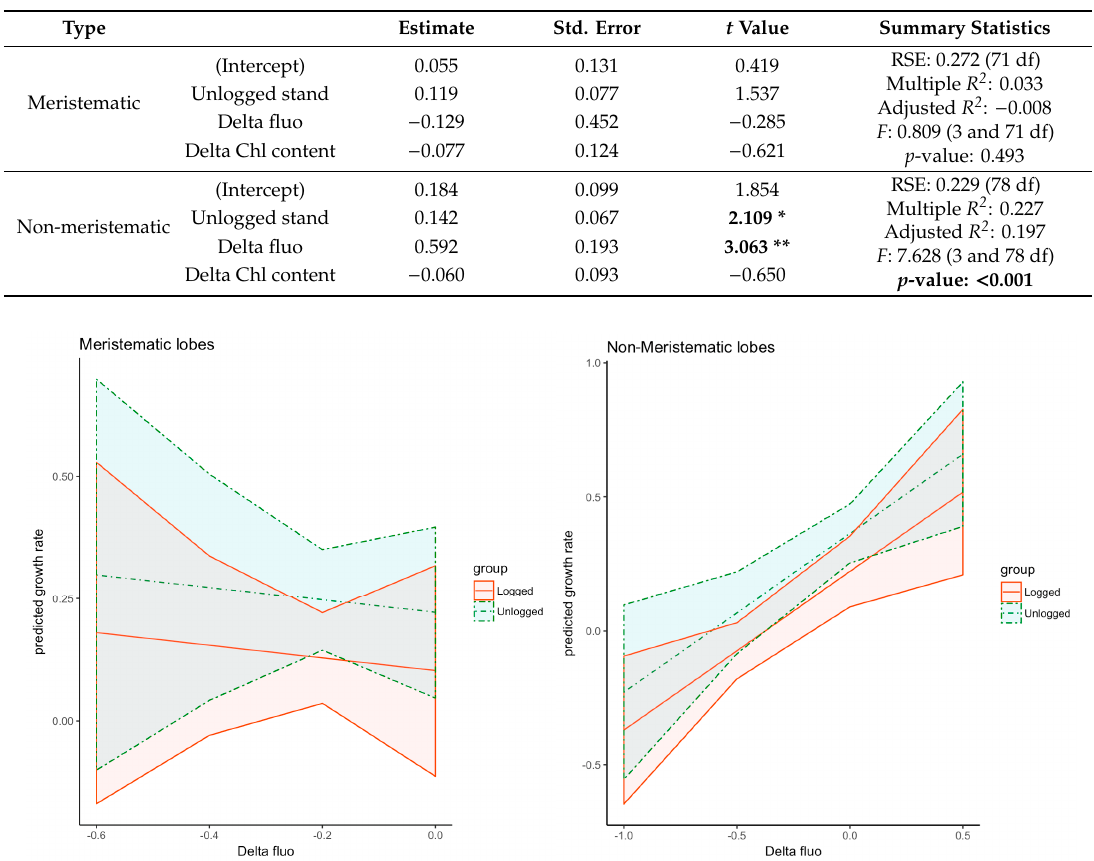
Table 2. Multiple Linear Regression Models describing the e ff ects of logging and vitality on growth rates both in meristematic and non-meristematic fragments. Estimates, Standard Errors, t values and p values (* p < 0.05; ** p < 0.01) are reported. Summary statistics also are reported for each model ( F statistics and p values).